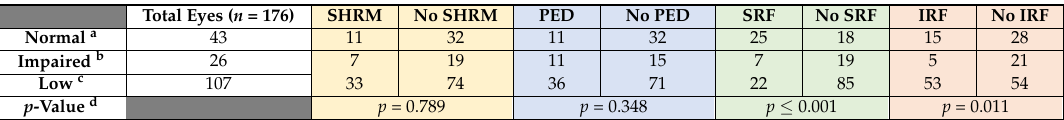
Table 2. Correlation between baseline morphological features and one year functional best